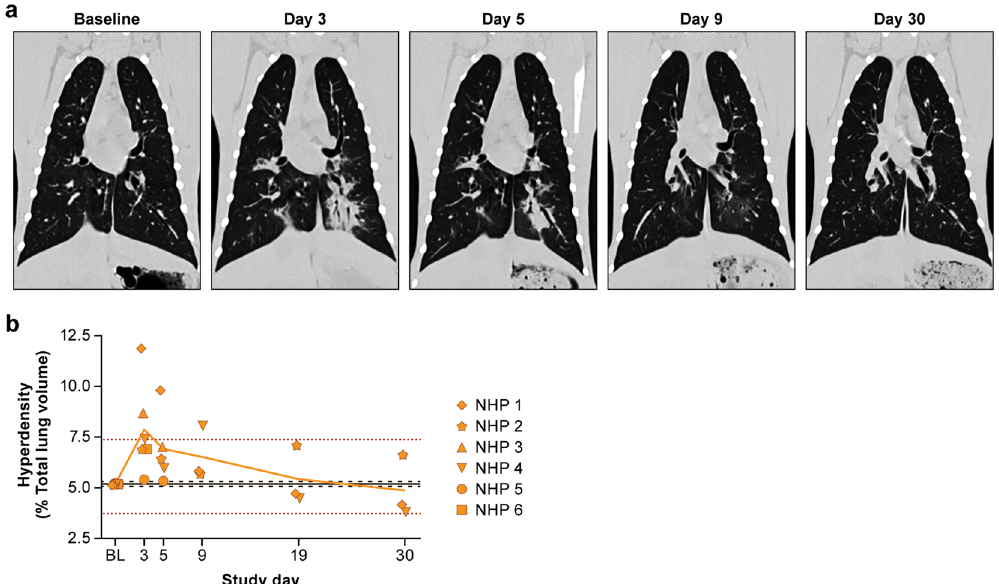
Figure 2. Percent change in lung hyperdensity (PCLH). ( a ) Representative lung field ( b ) Lung consolidation depicted as the percentage of the volume of hyperdense voxels in the total lung volume for each icMERS virus exposed animal. * Day 5 for NHP6 was omitted due to improper endotracheal tube intubation for the imaging breadth hold. Solid and dotted black lines indicate the baseline mean and 3 SD range of the hyperdense volume from ic-MERS-0 exposed animals included in this study. Dotted red lines indicate the upper and lower method range limits of MERS exposed rhesus monkeys (n =